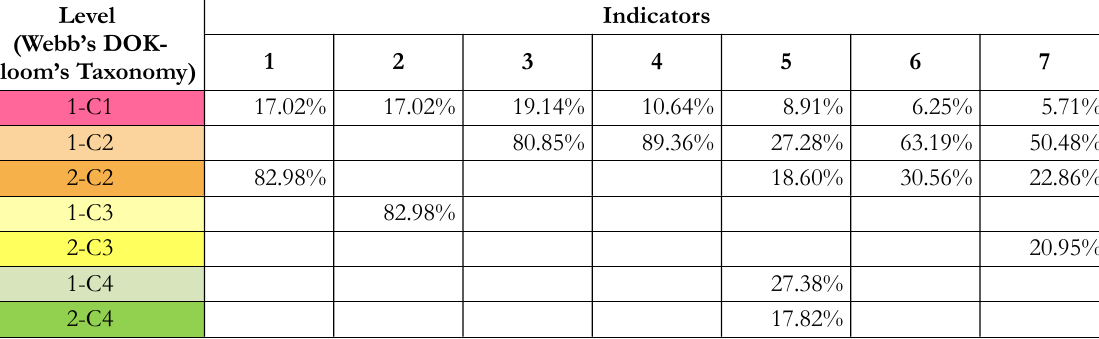
Table 3. Level of Students’ Thinking Skills on Each Indicator